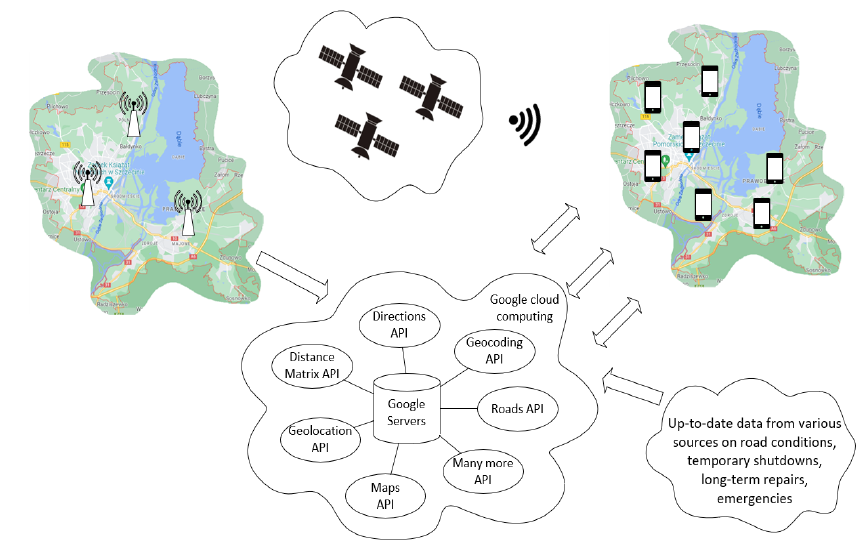
Figure 2. Google crowdsourcing model. Source: our studies described in [21].